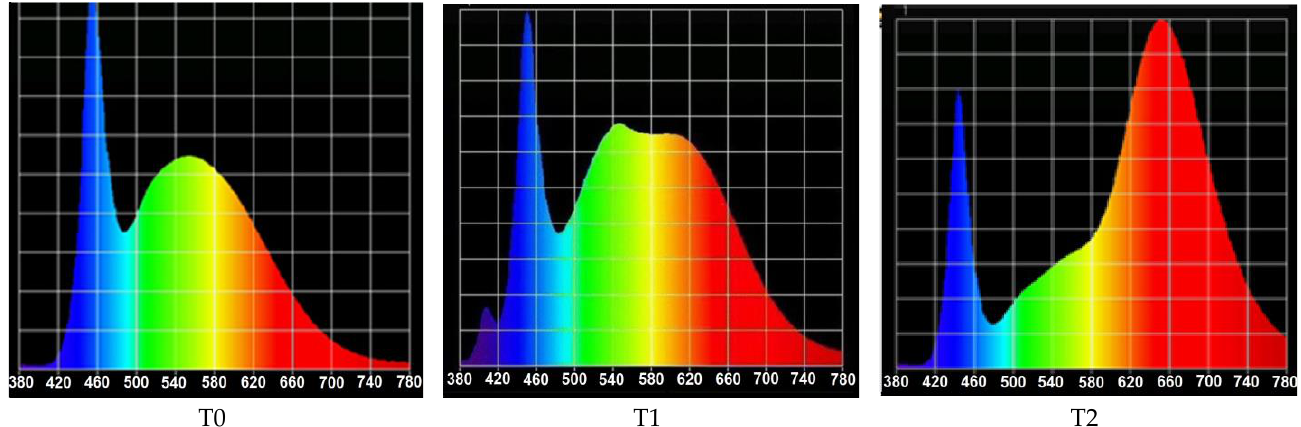
Figure 1. Distribution of photon flux in the spectrum from 380 to 780 nm for the three treatments [15]: T0: L18 T8 Roblan ® (control); T1: L18 NS1 Valoya ® (blue); and T2: L18 AP67 Valoya ® (red).